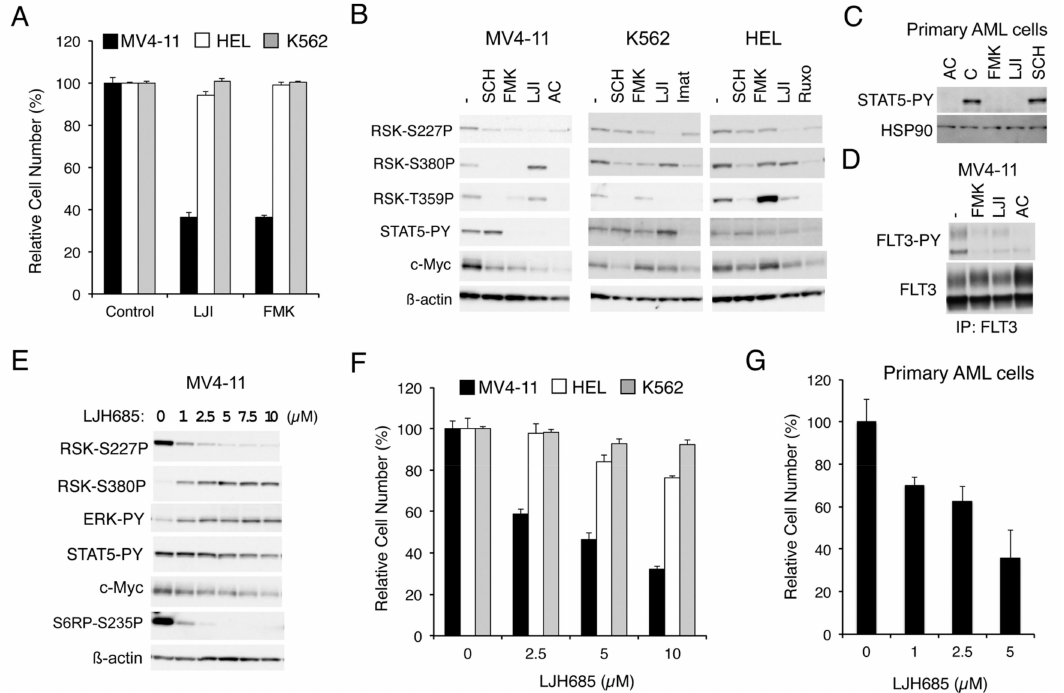
Figure 1. Inhibition of RSKs remarkably inhibits proliferation of leukemic cells dependent on FLT3-ITD but not BCR / ABL or JAK2-V617F. ( A ) MV4-11, HEL, or K562 cells were cultured for 48 h in the absence (Control) or presence of 20 µ M LJI308 (LJI) or 5 µ M FMK, as indicated. Viable cell numbers were measured by the colorimetric assay. Each column represents the mean of triplicate cultures, with error bars indicating standard errors, and is expressed as a percentage to the control cell numbers. ( B ) MV4-11, K562, or HEL cells were left untreated as control ( − ) or treated for 6 h with 0.5 µ M SCH772984, 5 µ M FMK, 20 µ M LJI308, 10 nM quizartinib (AC), 1 µ M imatinib (Imat), or 1 µ M ruxolitinib (Ruxo), as indicated. Cells were then lysed and subjected to immunoblot analysis with antibodies against indicated proteins. ß-actin was used for a loading control. Abbreviations: RSK-S227P, phospho-S227-RSK2; RSK-S380P, phospho-S380-RSK1; RSK-T359P, phospho-T359 / S363-RSK1; STAT5-PY, phospho-Y694-STAT5. ( C ) Primary acute myeloid leukemia (AML) cells expressing FLT3-ITD were left untreated as control (C) or treated for 6 h with 3 nM quizartinib, 5 µ M FMK, 20 µ M LJI308, or 0.5 µ M SCH772984, as indicated, and analyzed. HSP90 was used for a loading control. ( D ) MV4-11 cells were left untreated as control ( − ) or treated for 6 h with 5 µ M FMK, 20 µ M LJI308, or 1 nM quizartinib, as indicated, and lysed. Cell lysates were subjected to immunoprecipitation (IP) with ant-FLT3 antibody, followed by immunoblot analysis. FLT3-PY: Phospho-Y591-FLT3. ( E ) MV4-11 cells were treated for 6 h with indicated concentrations of LJH685 and subjected to immunoblot analysis. Abbreviations: ERK-PY, phospho-T202 / Y204-Erk; S6RP-S235P, phospho-S235 / S236-S6RP. ( F ) MV4-11, HEL, or K562 cells were cultured for 48 h with indicated concentrations of LJH685 and subjected to the colorimetric assay. ( G ) Primary FLT3-ITD-positive AML cells were cultured for 48 h with indicated concentrations of LJH685, and viable cell numbers were counted after trypan blue staining. Each column represents the mean of triplicate cultures, with error bars indicating standard